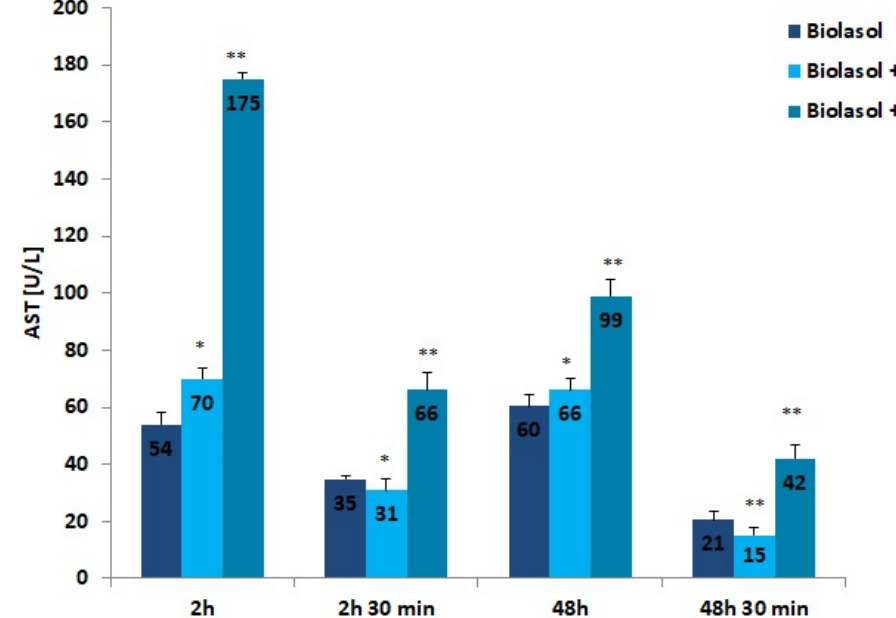
Figure 2. AST activity in the collected perfusates. The values are expressed as mean ± SEM. * p < 0.05; ** p < 0.01 compared to the control group (Biolasol).